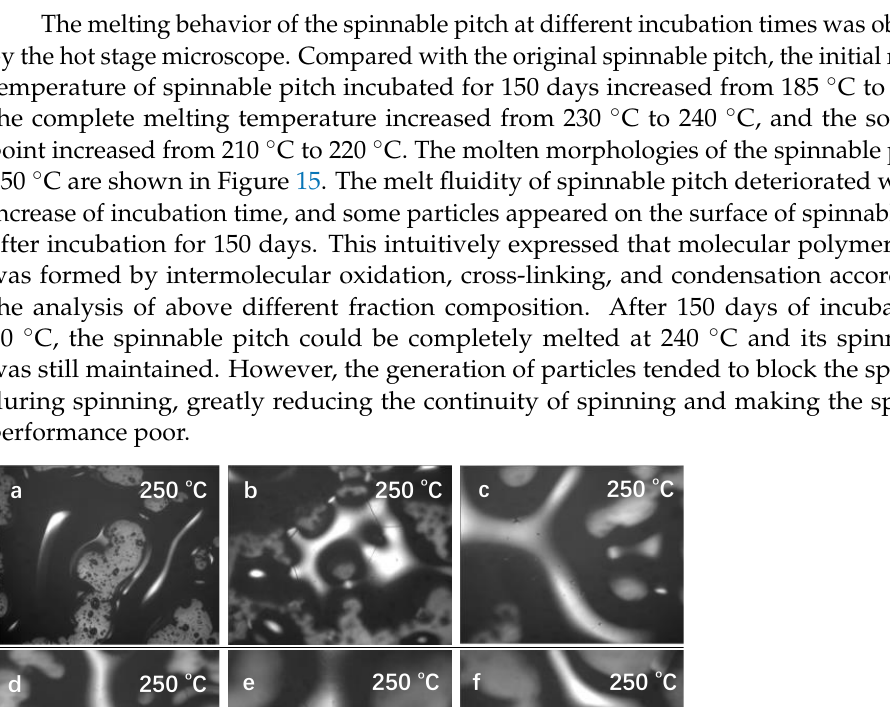
Figure 14. The 13 C-NMR spectra of the THFI fraction. Figure 14. The 13 C − NMR spectra of the THFI fraction.